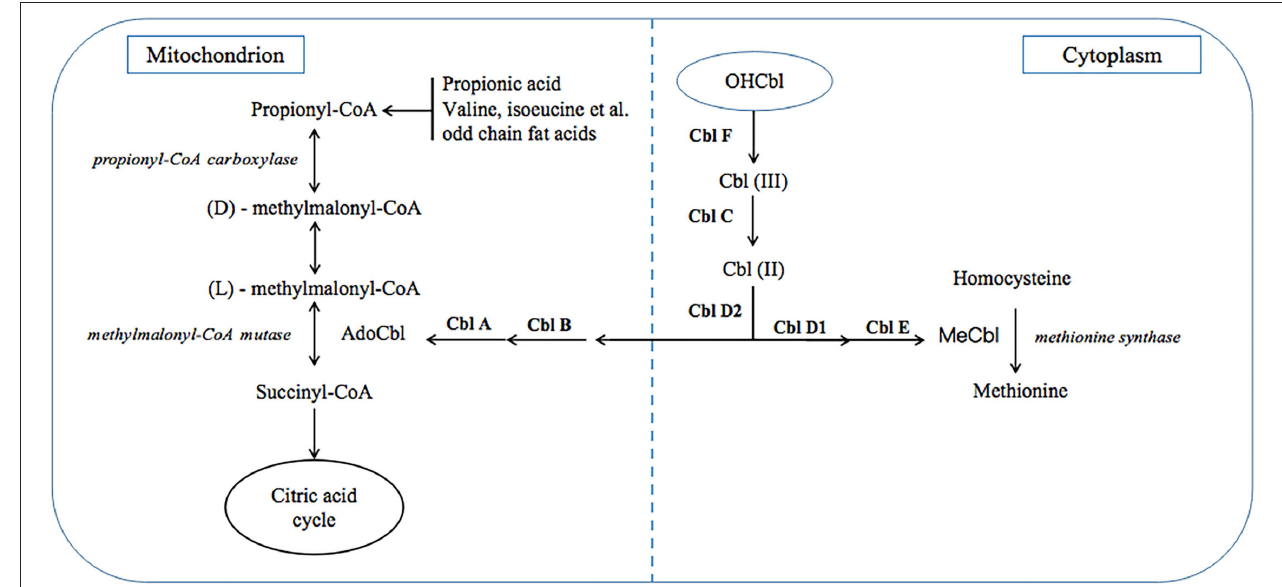
FIGURE 1 | Metabolic pathway of cobalamin and